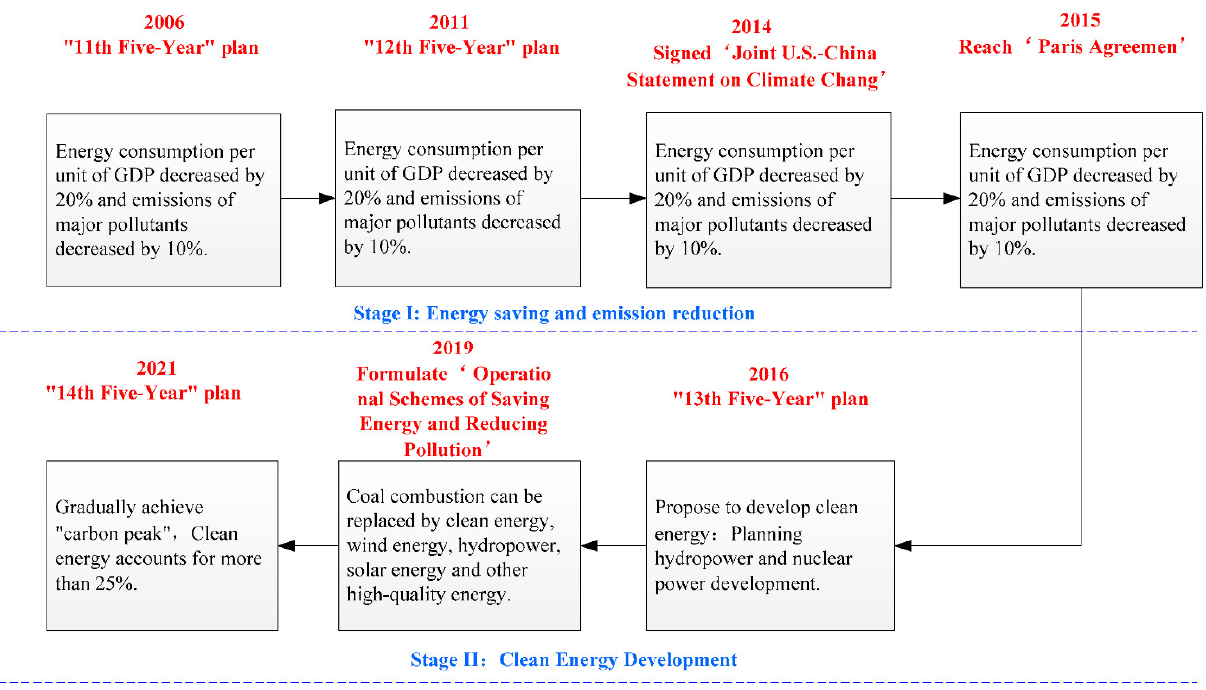
Figure 3. China’s clean energy policy process.